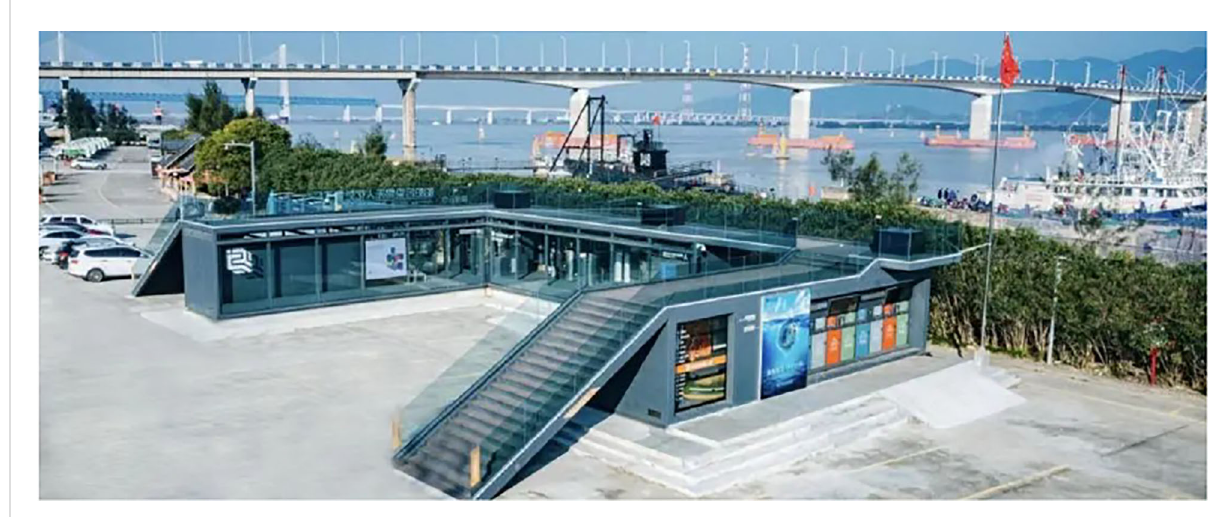
FIGURE 1 Marine plastic unmanned capacity reduction device: Blue Cloud Warehouse (to improve collectors ’ ef fi ciency and income) (Regenerative Plastics,